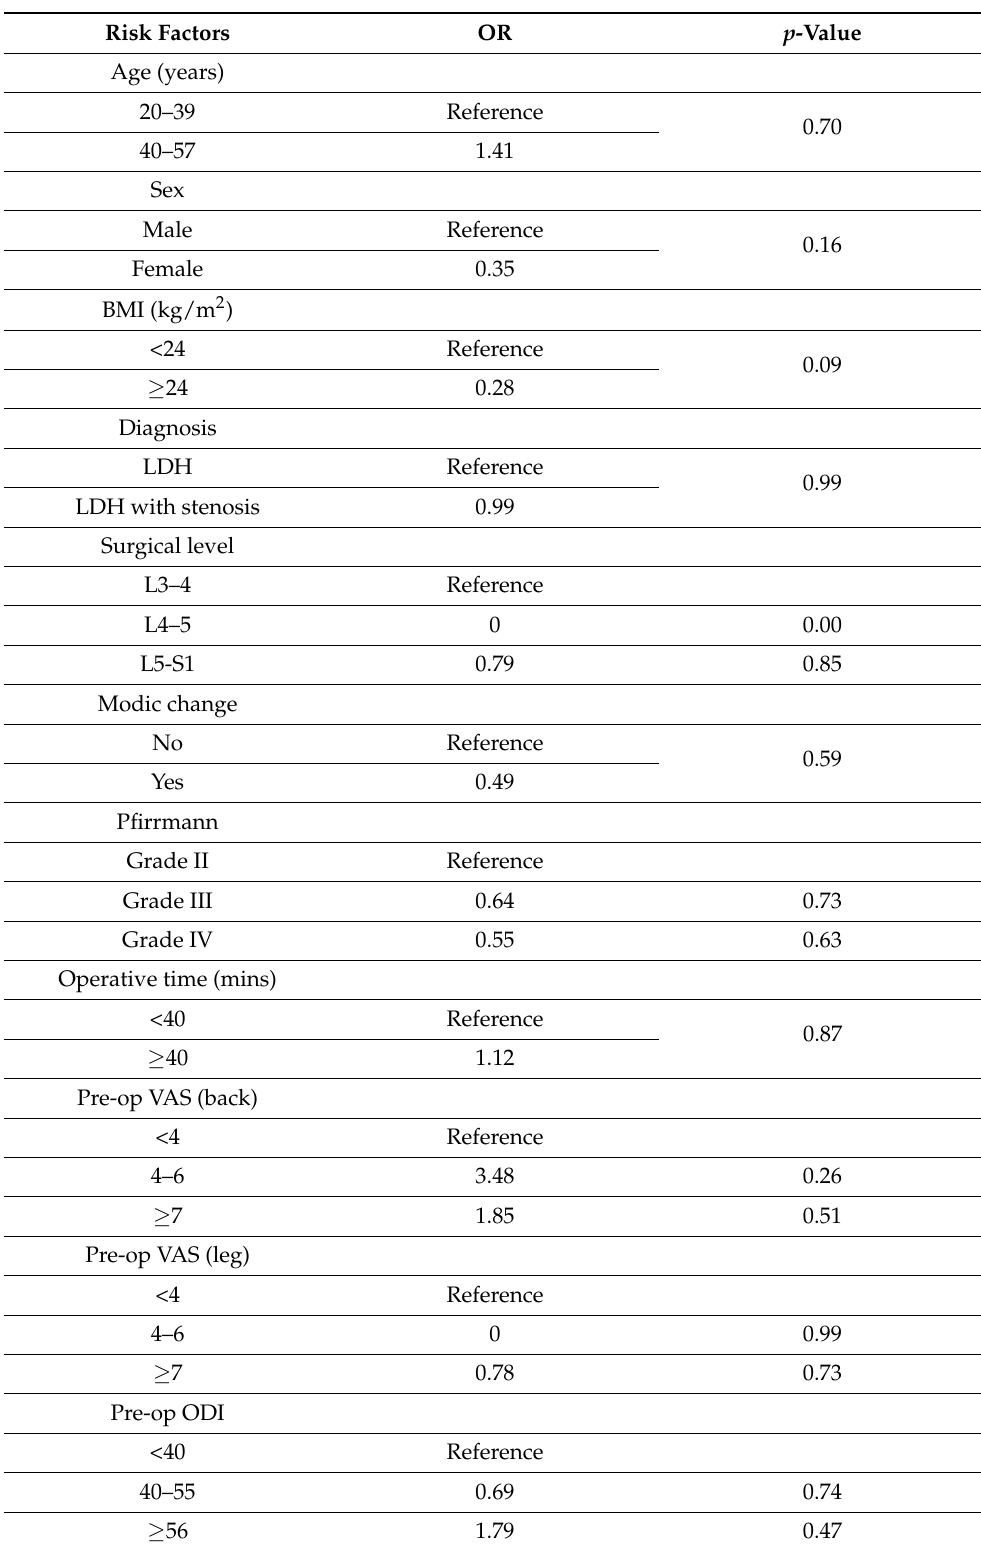
Table 6. Logistic regression analyses for the risk factors of rebound